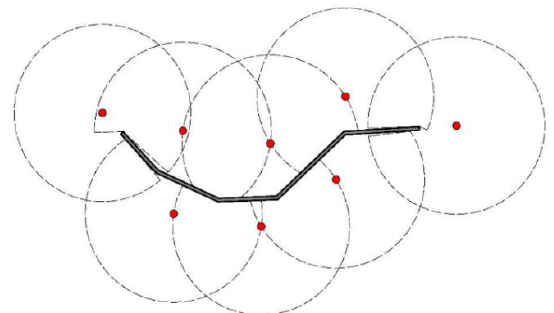
Figure 3. Example of survey planning with Laser Scanner, in red the stations, the dotted circles the scanning area and in the middle of the wall section object of the